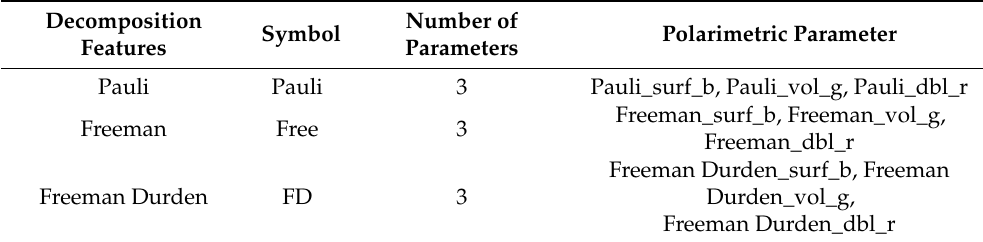
Table 2. Polarimetric features obtained from the PALSAR-2 data.